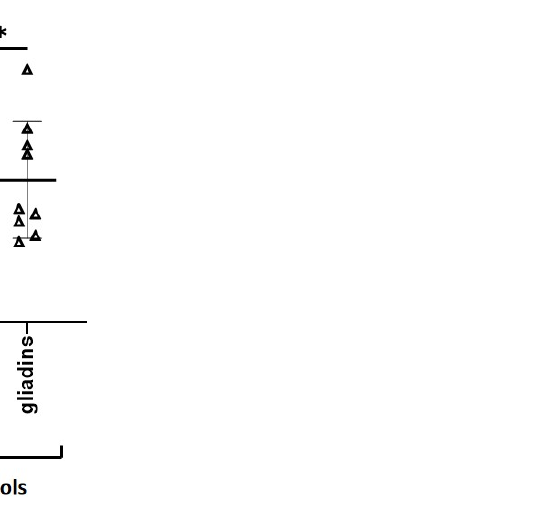
Figure 4. Percentage of FoxP3+ cells in total CD4+ cells. The paired t -test revealed significant differences in gliadin-induced increase in FoxP3+ regulatory T cells in patients with NCGS ( n = 9) and healthy controls ( n = 9) compared to medium control. * p < 0.05, *** p < 0.001. Exemplary Fluorescence-activated cell sorting (FACS) panels are shown in Supplementary Figure S2.